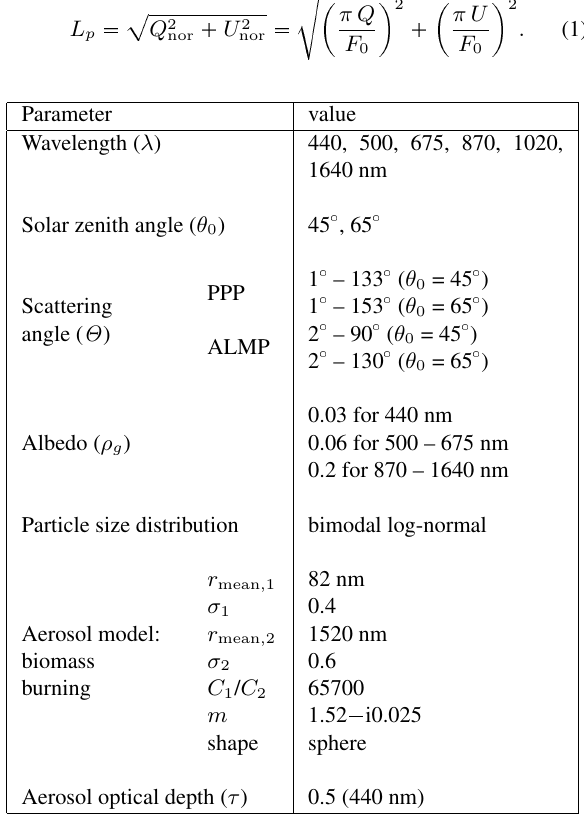
Table 1. Input parameters for simulating of polarization measurements of the polarized sun-sky